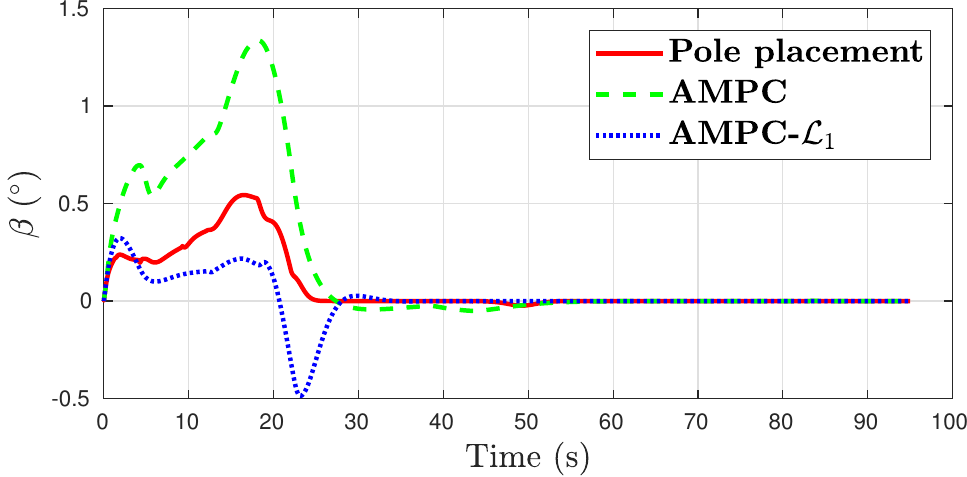
Figure 9. Sideslip regulation error for aerodynamic uncertainty case. Compared to the nominal case in Figure 6, the pole placement and AMPC- L 1 con- trollers achieved similar performance in yaw-rate regulation as shown in Figure 10. How- ever, the performance of the baseline AMPC slightly